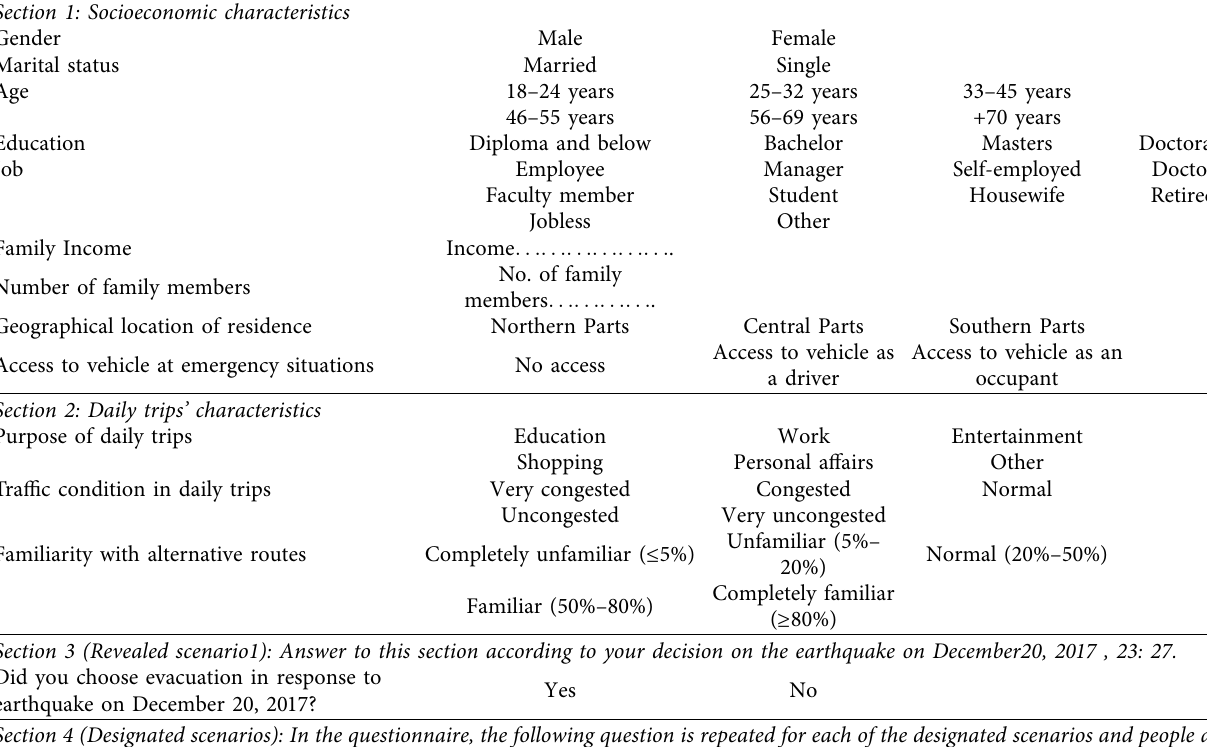
Table 4: The abridged form of